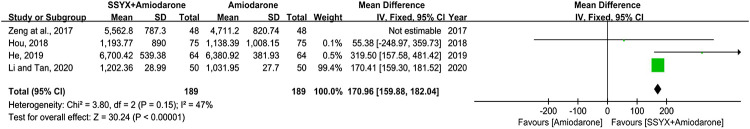
Forest plot of comparison: SSYX-amiodarone vs. amiodarone alone: VPCs.